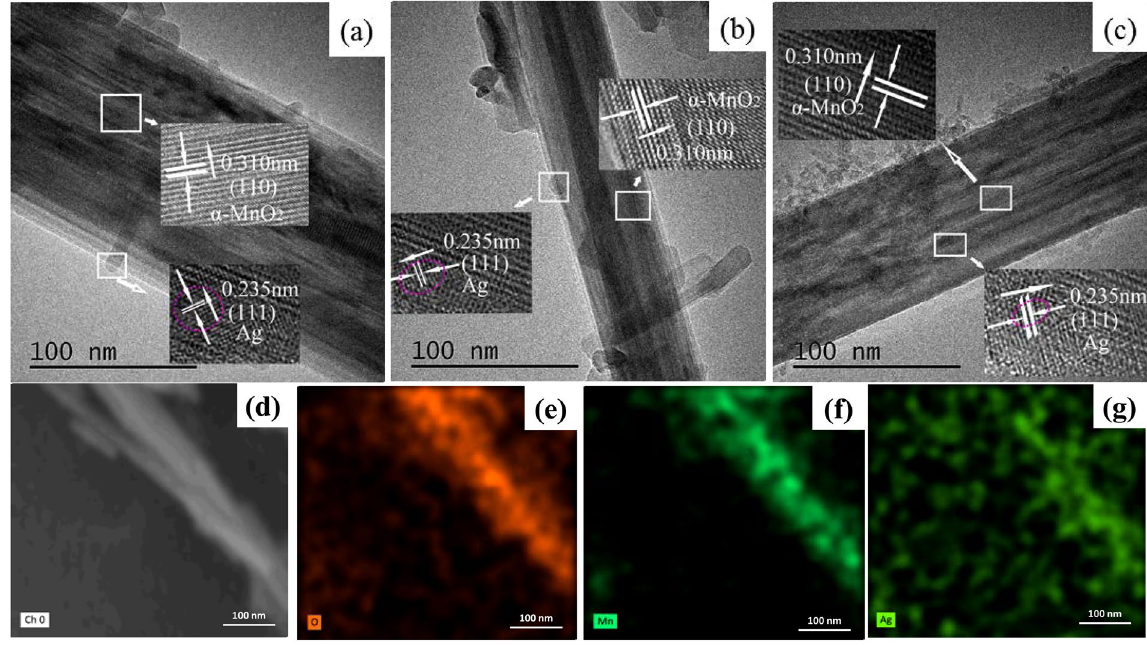
Figure 7. TEM micrograph of the ( a ) T-Ag/MnO 2 , ( b ) R-Ag/MnO 2 , ( c ) R CB -Ag/MnO 2 with aluminum sol; ( d – g ) SEM element mapping images of the R-Ag/MnO 2 .